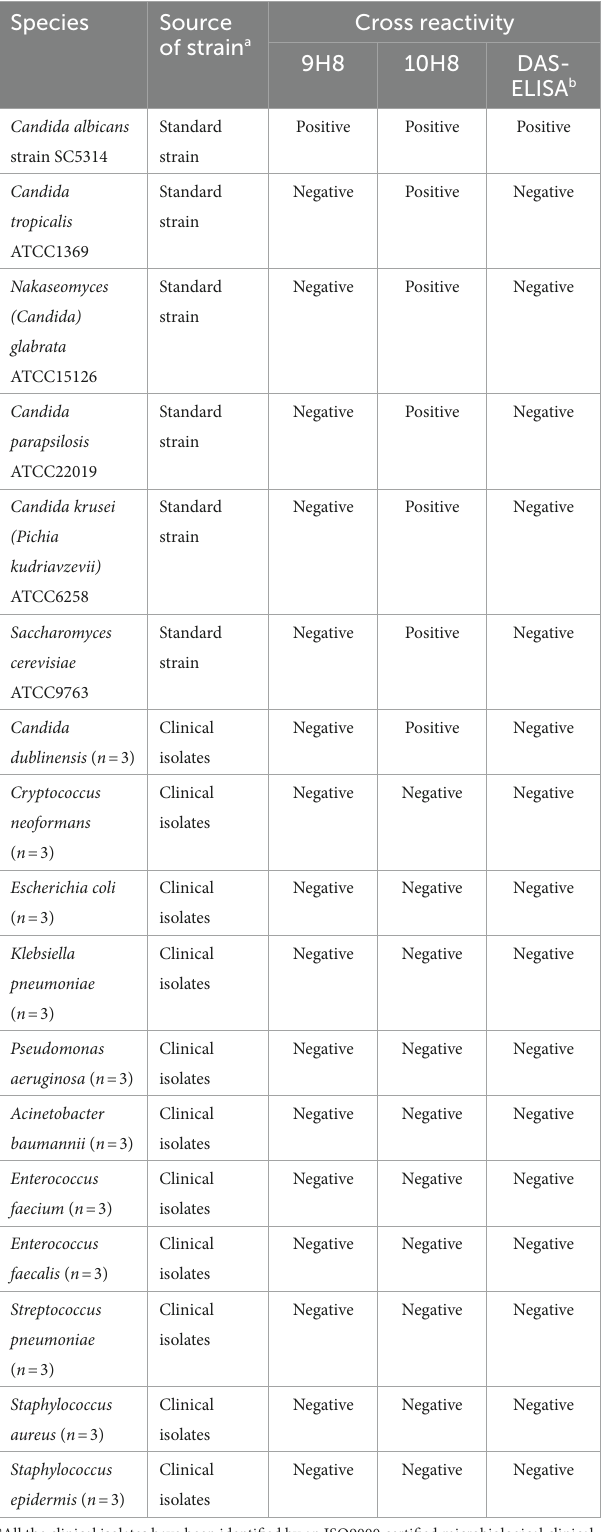
TABLE 1 Reaction specificity of 9H8, 10H8 mAbs, and the DAS-ELISA.